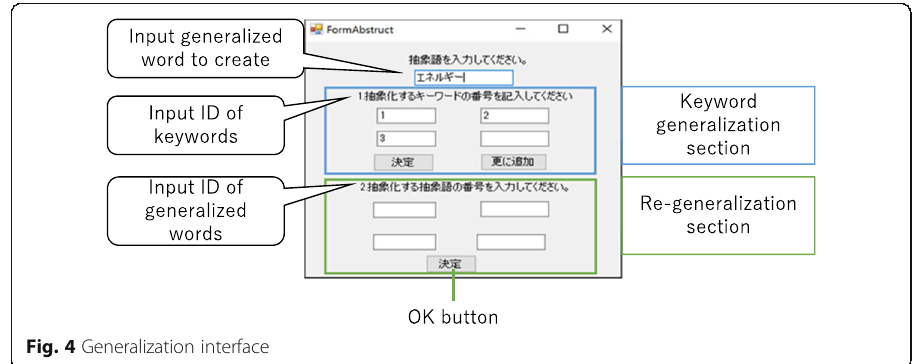
Fig. 4 Generalization